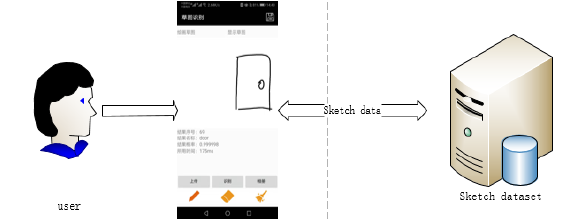
Figure 4. Illustration of sketch recognition application on mobile